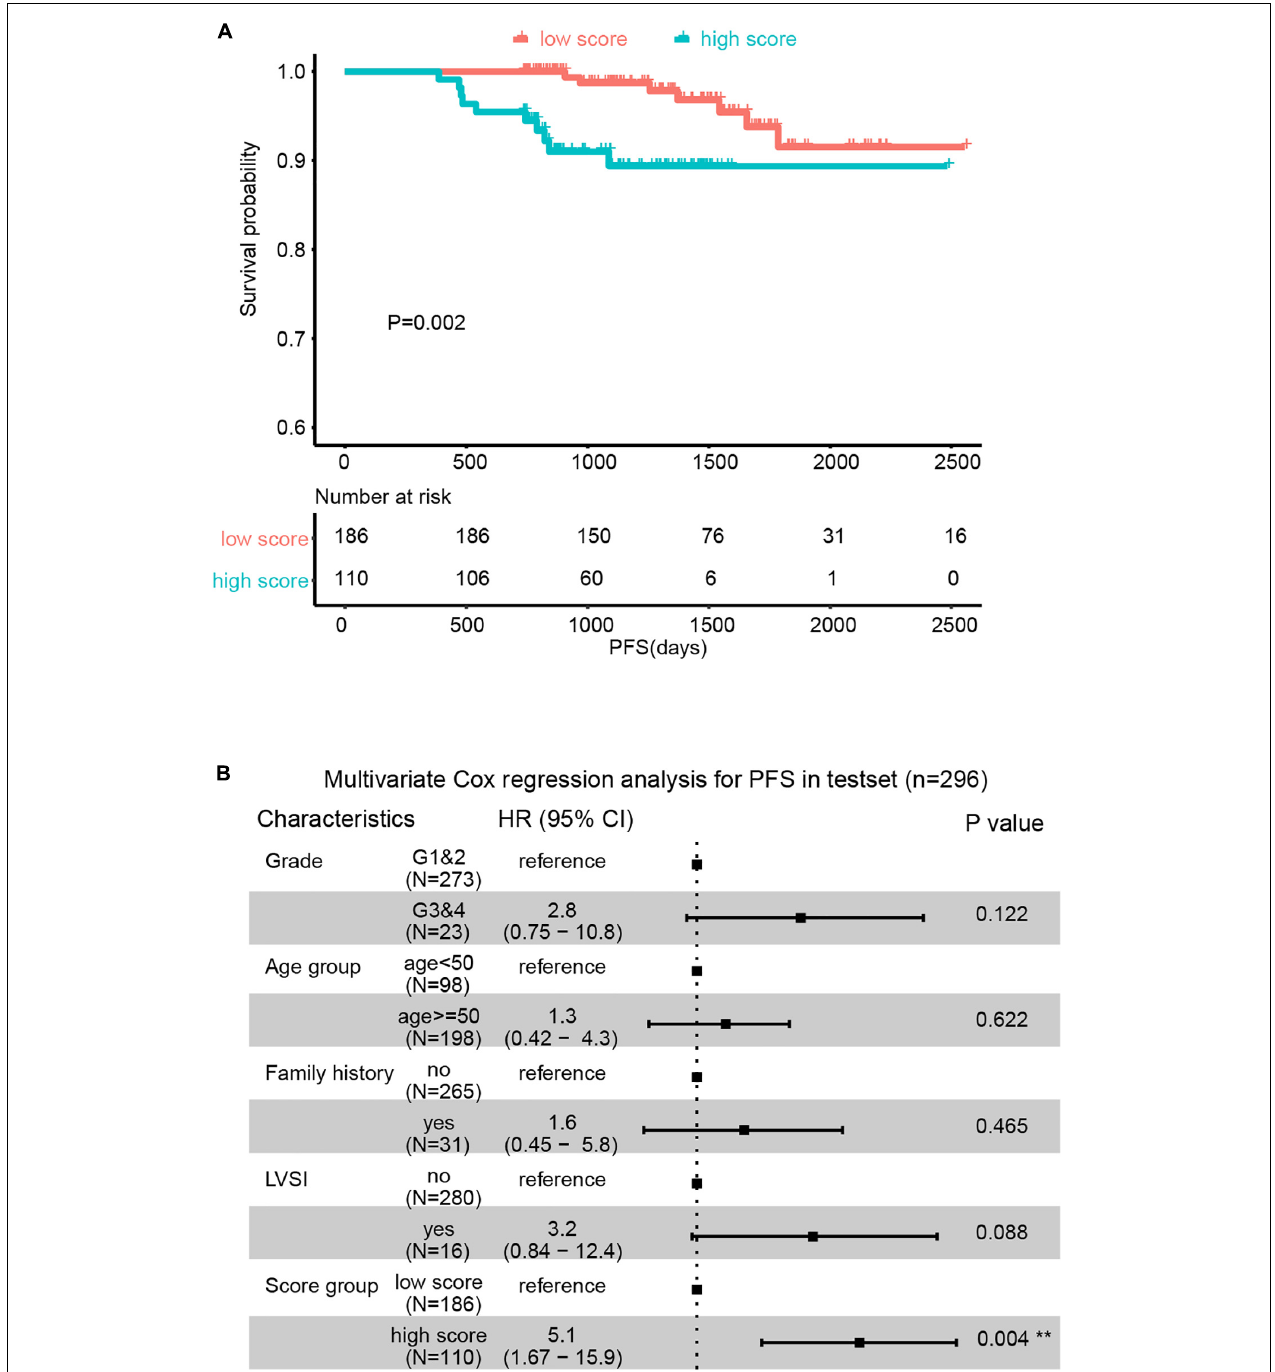
FIGURE 4 | The predictive value of Endometrial Cancer Prognostic-Related Metabolic (ECPRM) Score was validated in an external cohort. (A) Kaplan-Meier survival analysis revealed the strong association between high ECPRM Score and shorter PFS in the testset. (B) Forest plot of multivariate Cox regression analysis showed high ECPRM Score was significantly associated with shorter PFS in the